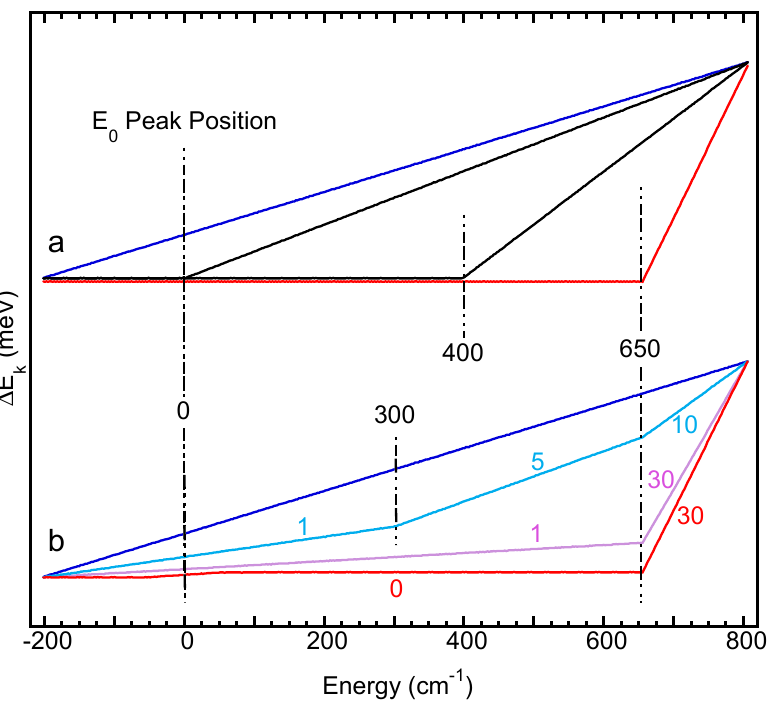
Figure 8. The energy shift per data point ( Δ E k ) distributed from an assumed total 0.8 meV energy drift per scan using the Equation (2) but for NRVS data with different scanning parameters: ( a ) an even time scan (blue) vs. the 30/0 s/p jump scan (red) which changes the scanning time at 650 (red), 400 (right black) and 0 (left black) cm − 1 respectively; and ( b ) an even time scan (blue) vs. the 10/5/1 s/p sectional scan (light blue), the 30/1 s/p sectional scan (purple) and the 30/0 jump scan (red).